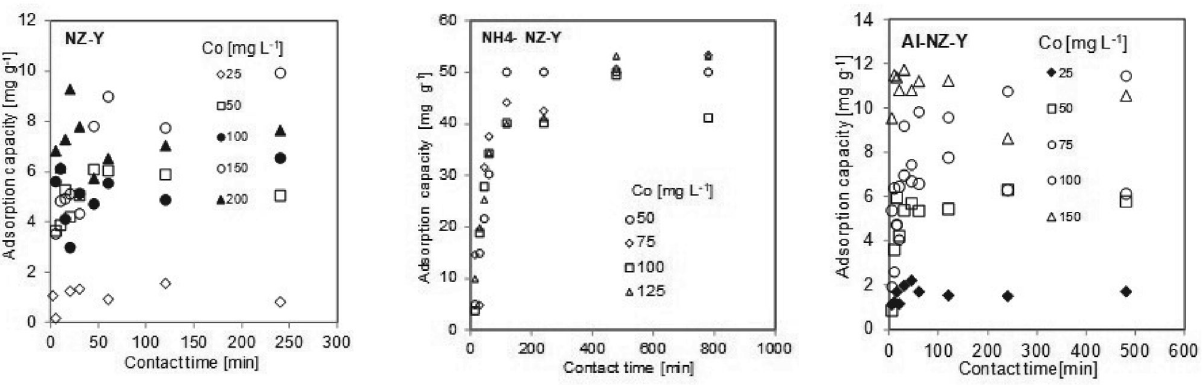
Figure 3. Adsorption capacity of NZ-Y, NH4-NZ-Y and Al-NZ-Y for removal of As(V) as a function of contact time.